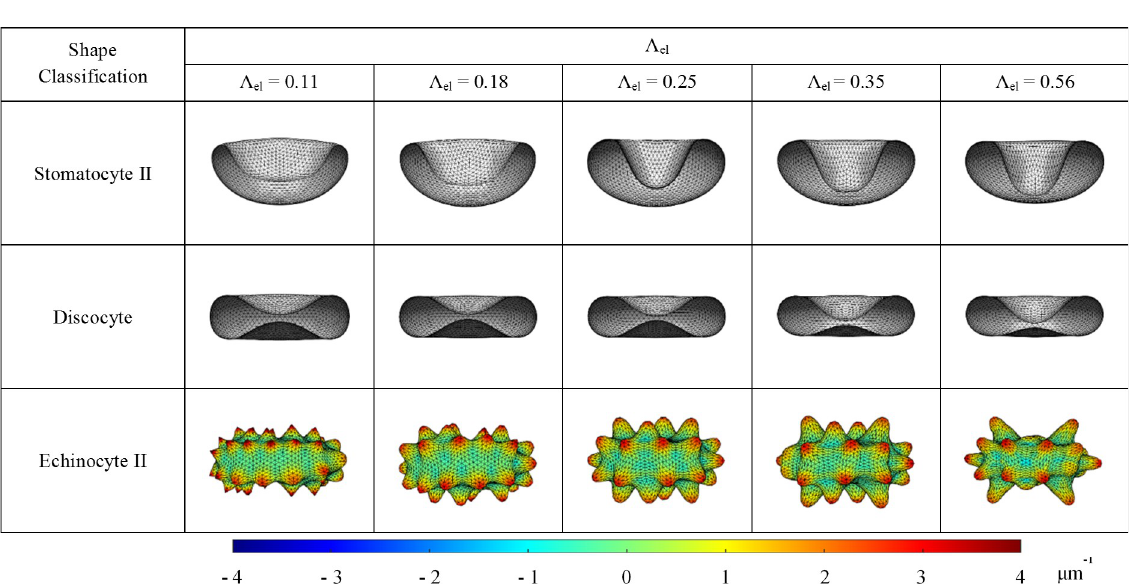
= 0.11, (cid:0) � el V ; i